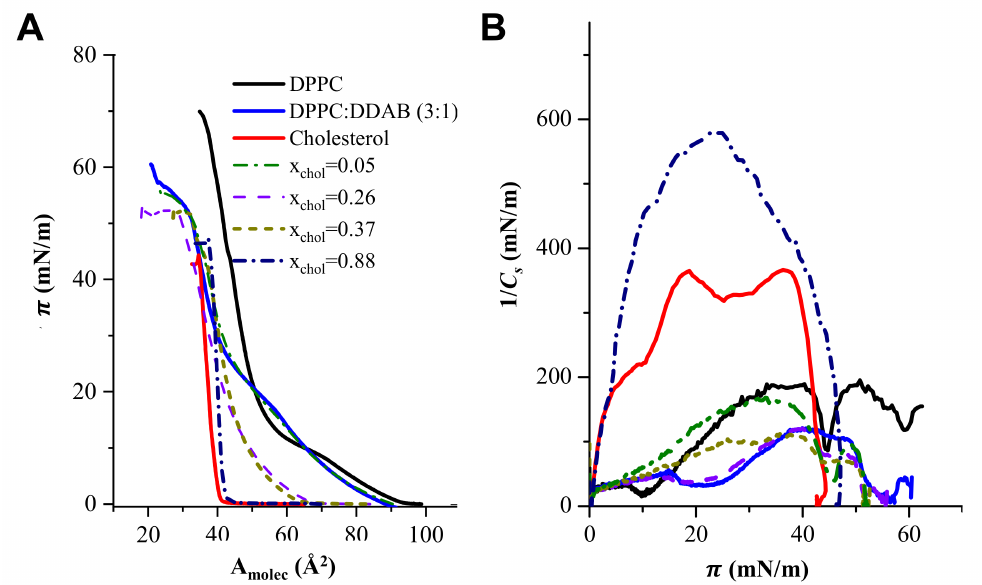
Figure 3. ( A ) Langmuir isotherms of monolayers of pure DPPC, DPPC:DDAB in a molar ratio 3:1, cholesterol and ternary monolayers of DPPC:DDAB 3:1 and cholesterol at some selected mole fractions of cholesterol (x Chol ). ( B ) 1/ C s vs. surface pressure plots for monolayers of pure DPPC, DPPC:DDAB in a molar ratio 3:1, cholesterol and ternary monolayers in panel ( A